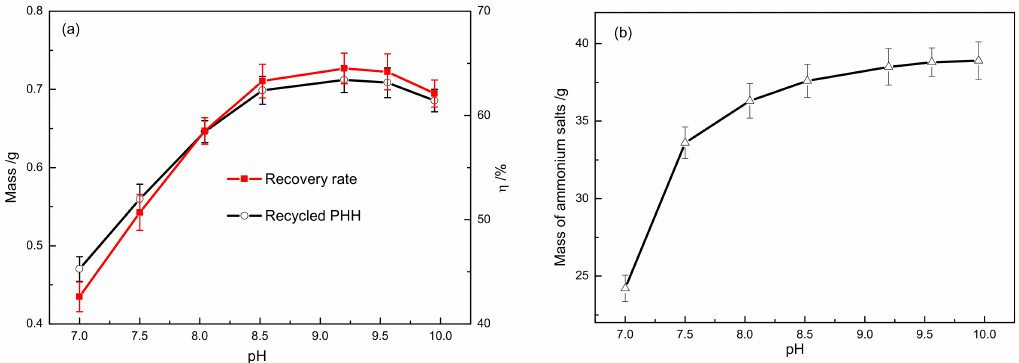
Figure 2. Effects of pH value on the mass of recycled PHH and recovery rate η ( a ), as well as mass of recycled ammonium salts ( b ) with solvent ratio 1 at 20 ◦